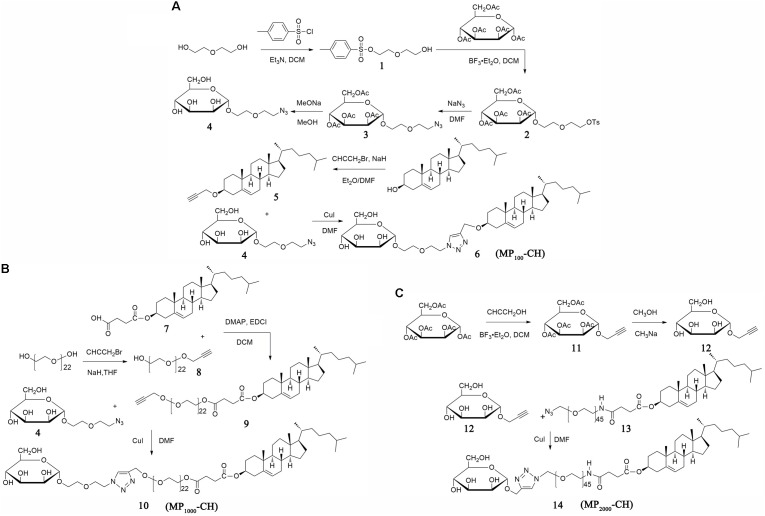
Synthesis of MPn-CHs. Schematic of the synthetic steps for MP100-CH (A), MP1000-CH (B), and MP2000-CH (C), respectively.